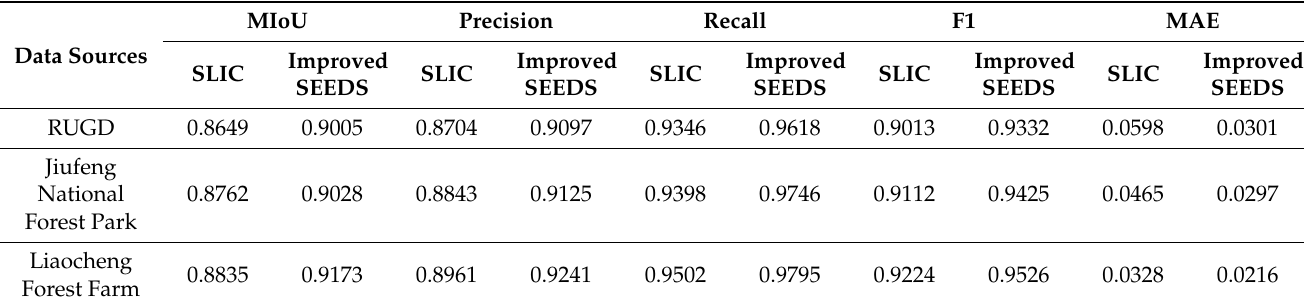
Table 1. Evaluation of unstructured road models in forest areas from the perspective of image segmentation.